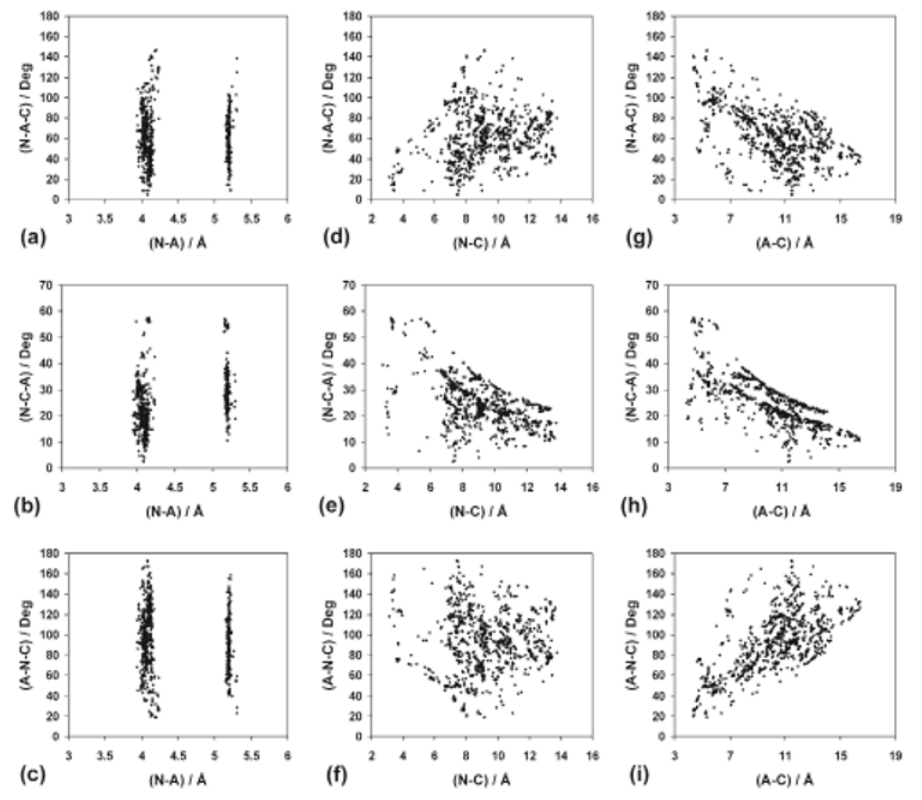
Figure 6. Nine different types of distance-angle maps, regarding the second subgroup of pharmacophore elements, for the S[4] stereoisomer: ( a ) the ( N-A ) – ( N-A-C ), ( b ) the ( N-A ) – ( N-C-A ), ( c ) the ( N-A ) – ( A-N-C ), ( d ) the ( N-C ) – ( N-A-C ), ( e ) the ( N-C ) – ( N-C-A ),